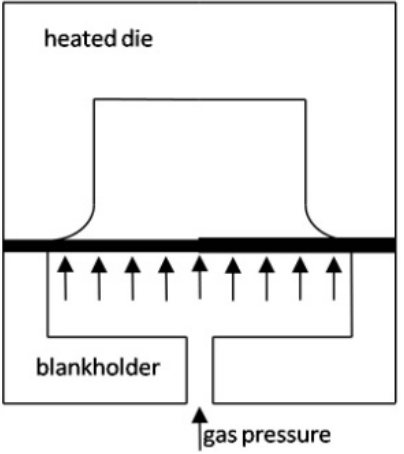
Figure 1. Scheme of the blow forming process.